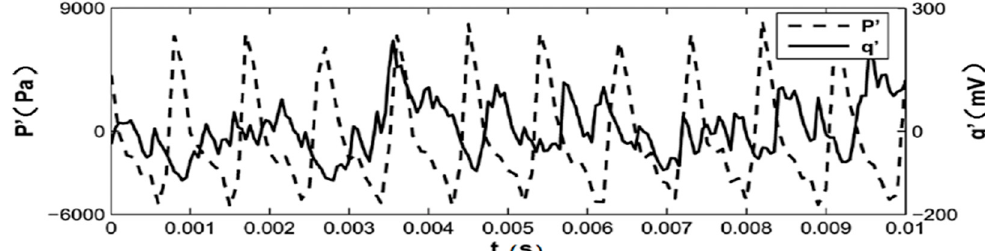
Figure 4. An example of the time series data of heat release (q’) and pressure (p’) showing instability in a combustor [18].